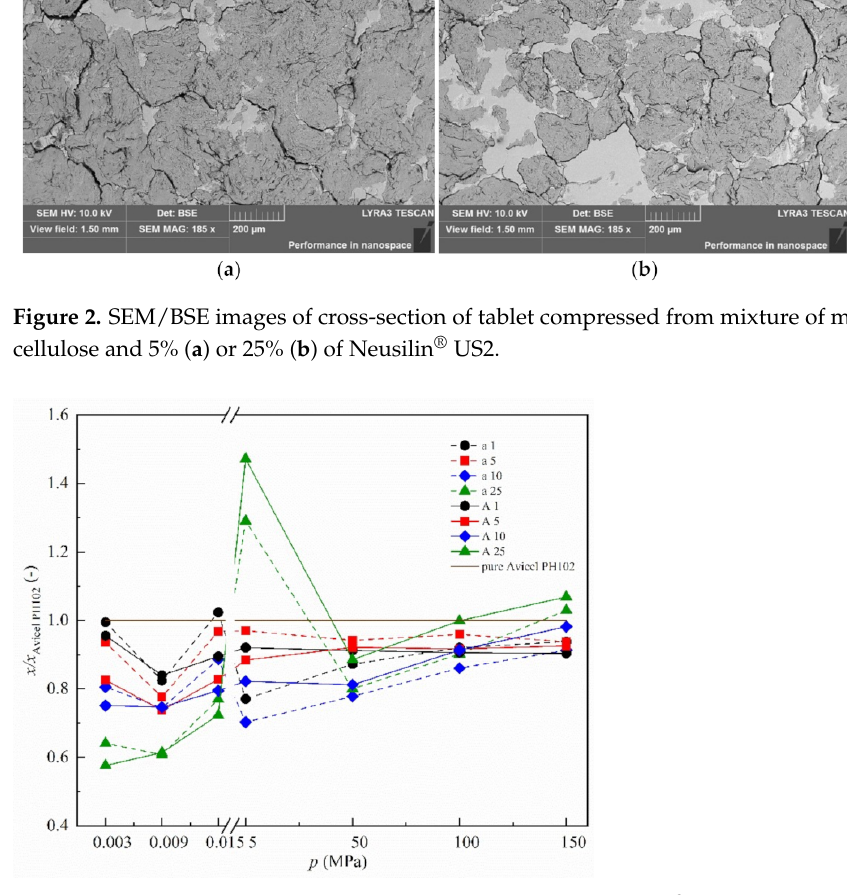
Figure 3. Effect of applied pressure on mixture containing Neusilin ® US2. Samples are identified by X-Y abbreviation where X = A-the coarse fraction of microcrystalline cellulose (—), X = a-the finer fraction of microcrystalline cellulose (- - -), Y = 1, 5, 10 and 25—1% ( ● ), 5% ( █ ), 10% ( ◆ ) and 25% ( ▲ ) of Neusilin ® US2. The x/x Avicel PH102 means the ratio of the value measured for the mixture to the value measured for pure microcrystalline cellulose. The x means the effective angle of internal friction for applied pressure up to 15 kPa and tensile strength for remaining applied pressures. (Standard deviation is not presented due to the graph